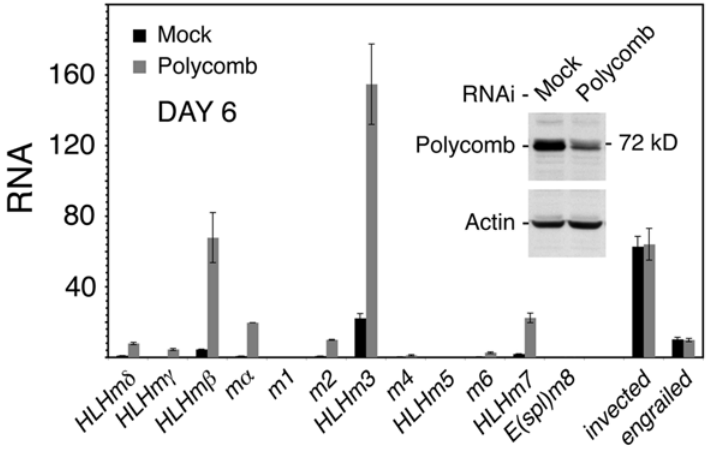
Figure 4. Effects of Polycomb on E(spl)-C and invected-engrailed transcripts in BG3 cells. The graph shows transcript levels in mock-treated BG3 cells (black) and in Polycomb RNAi-treated cells (gray) six days after treatment. The western blot shows the Polycomb protein knockdown ( , 70%) on day 6. All transcripts are relative to HLHm d in mock control cells. Similar results were obtained in three experiments.